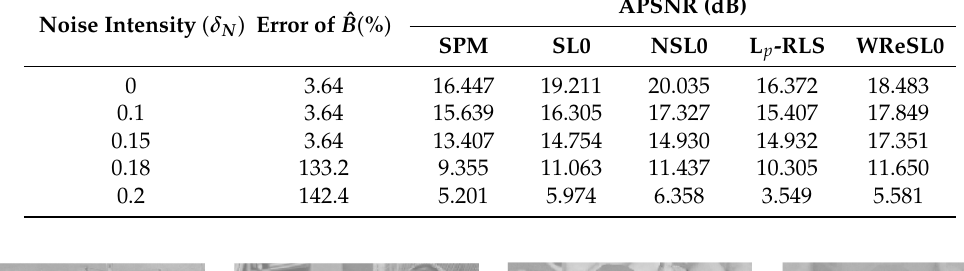
Noise Intensity ( δ N ) Error of ˆ B ( % )